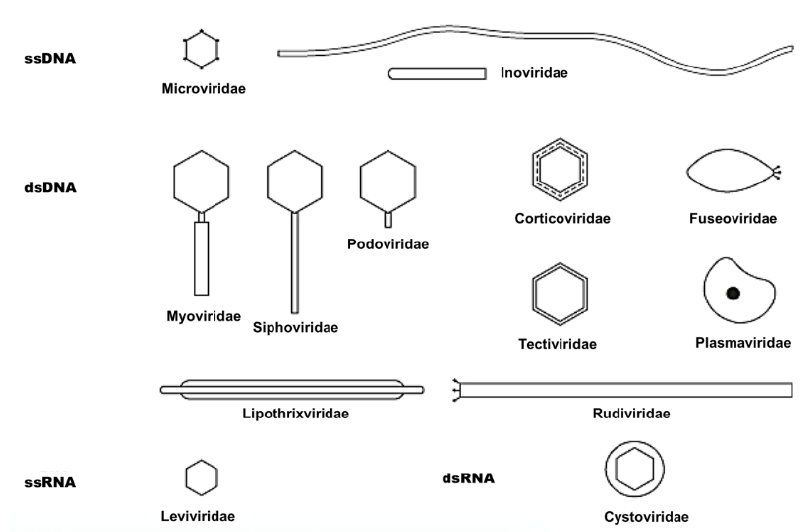
Figure 1. Schematic representation of major groups of bacteriophages. Reproduced with permission from reference [42] .